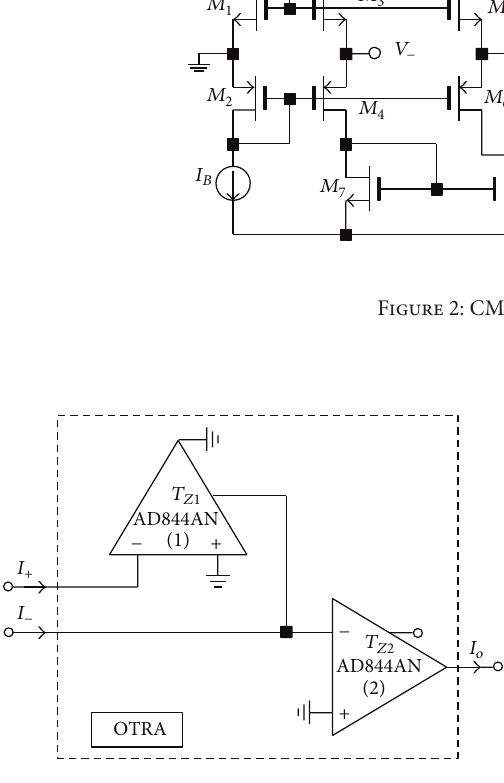
Figure 3: OTRA constructed using commercially IC